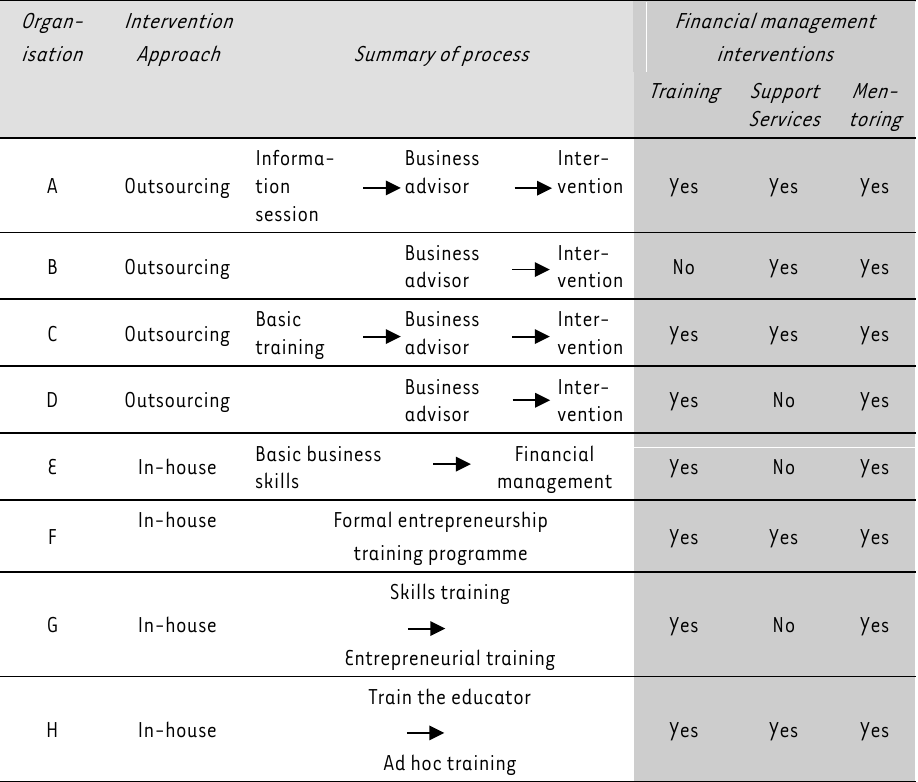
TABLE 2: Overview of financial management interventions